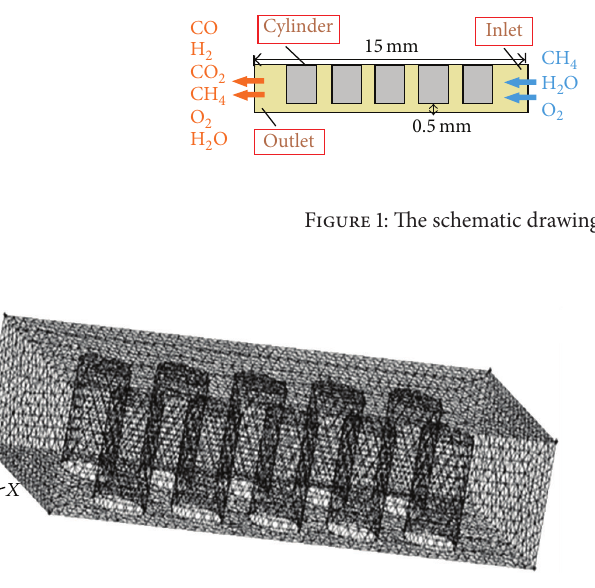
Figure 2: Three-dimensional mesh of the microchamber